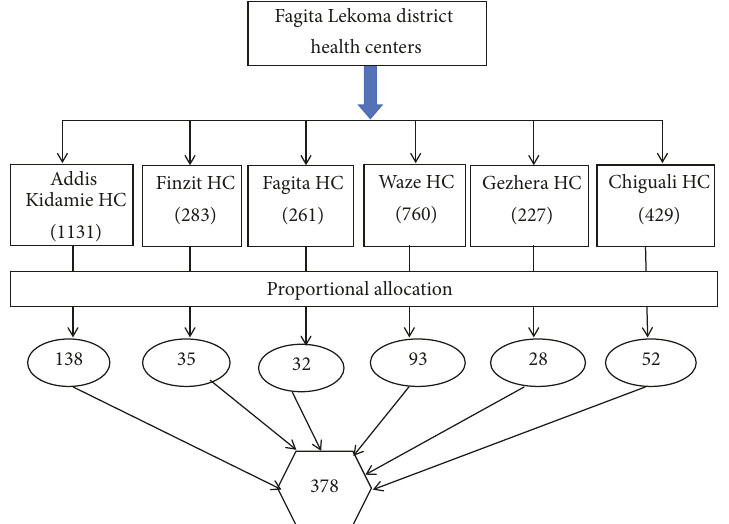
Figure 1: Schematic presentation of the sampling